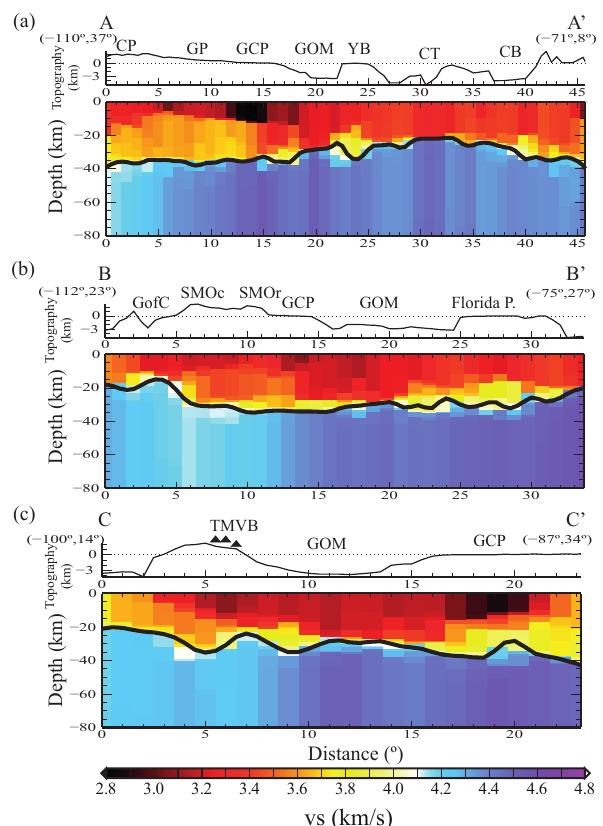
Figure 10. Shear wave velocity along the cross-sections delineated in Fig. 9; (a) A-A’, (b) B-B’, and (c) C-C’. The figure shows moho depth (thick black line), topography (thin black line above the ve- locity profile), and sea level (dashed line). CB denotes Colombian Basin; CP Colorado Plateau; CT Cayman Trough; Florida P. Florida Peninsula; GCP Gulf Coastal Plain; GofC Gulf of California; GOM Gulf of Mexico; GP Great Plains; SMOc Sierra Madre Occidental; SMOr Sierra Madre Oriental; TMVB Trans-Mexican Volcanic Belt; and YB Yucatan Block.